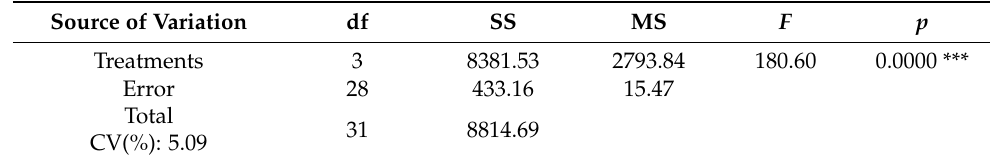
Table 2. Analysis of variance of the in vitro antagonism effect of fluorescent Pseudomonas strains against Pyricularia oryzae Triticum lineage. Source of Variation df SS